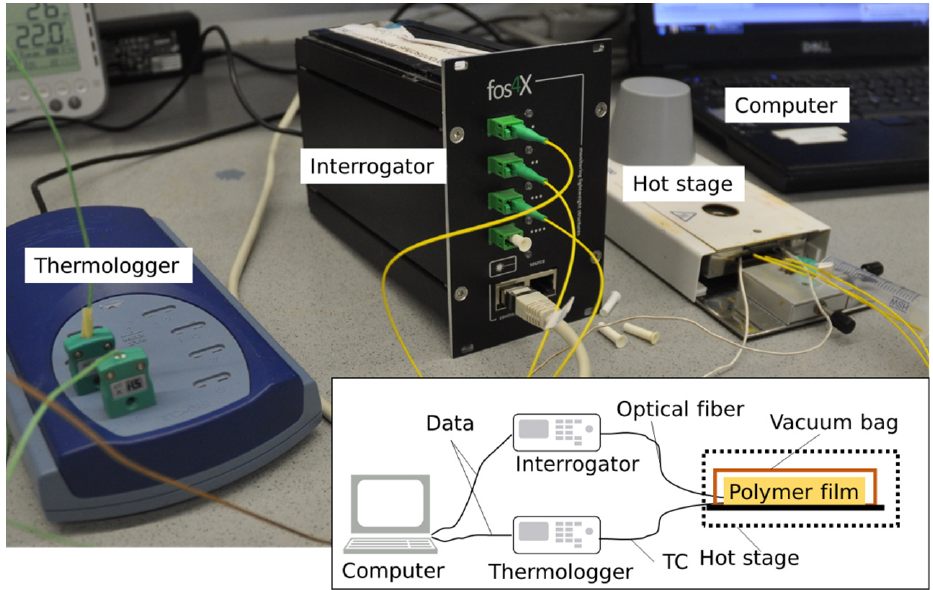
Figure 4. Measurement setup using SMF28e optical fibers and thermocouples of (TC) Class 1 type K. 3. Amorphous Thermoplastic Polymers: Polyetherimide (PEI), Polyethersulfone